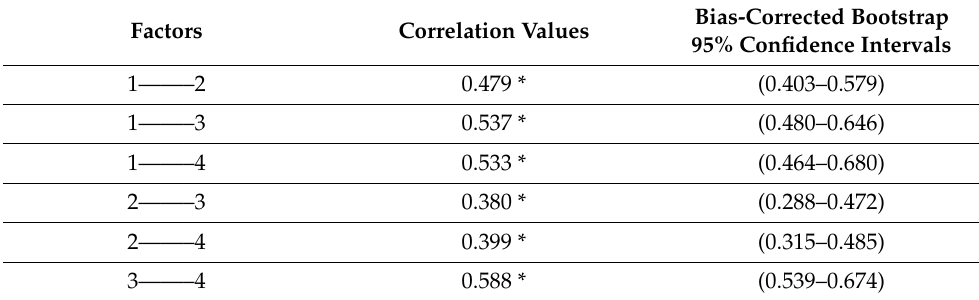
Table 5. Correlations (and 95% confidence intervals) between the factors of the obtained model. Factors Correlation Values